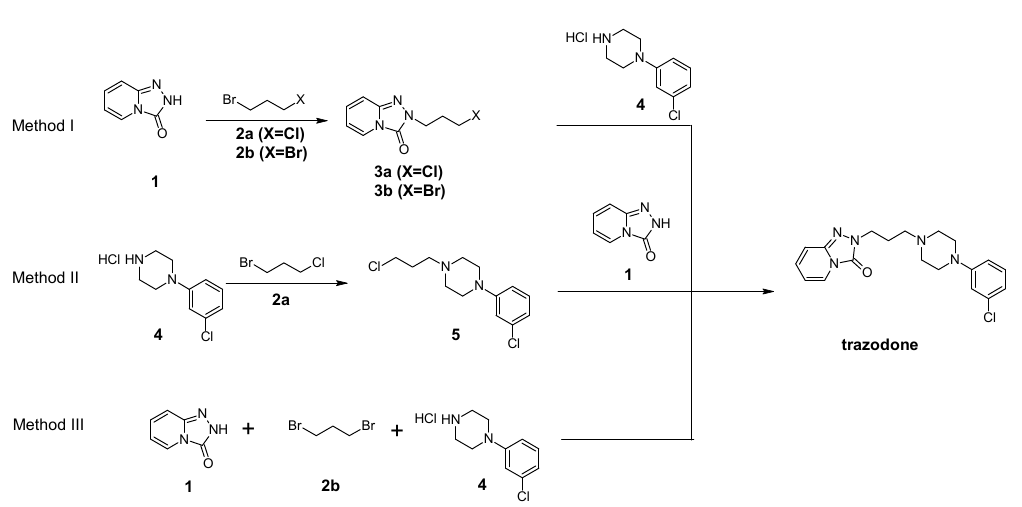
Scheme 1. Methods for obtaining